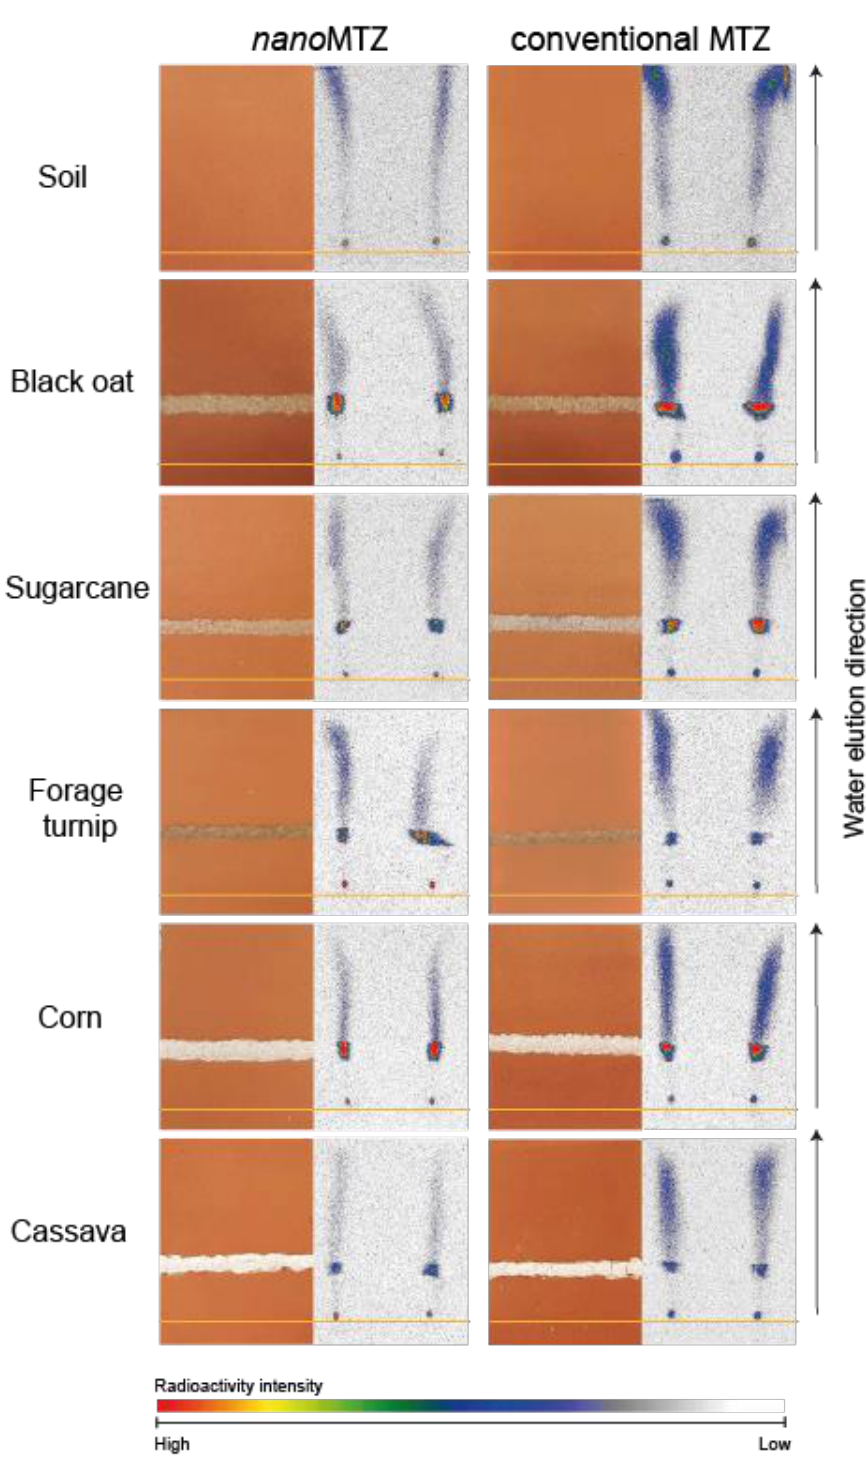
Figure 6. Qualitative mobility data of 14 C-metribuzin with nanoformulation (left column) and conventional formulation (right column), in deep soil with fresh organic residue barrier and soil without organic material barrier. The orange line is the base herbicide application. Images to the right in each column indicate the soil-TLC plate photographs and images to the left in each column indicate TLC plate autoradiographs after water elution and herbicide mobility in the plates. Colors indicate radioactivity signal intensity.